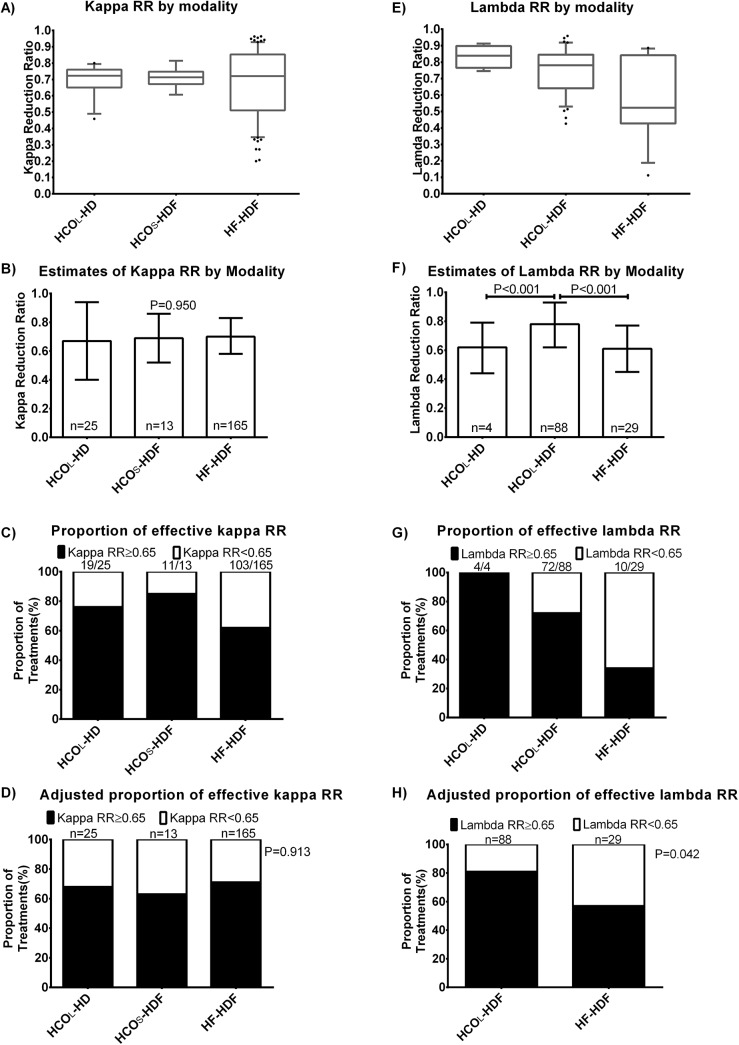
Free light chain reduction ratio by modality of renal replacement therapy.The left panel shows A) the crude reduction ratio (RR) of kappa free light chain by haemodialysis (HD) or haemodiafiltration (HDF) using large (2.1 m2) high cut-off filters (HCOL), small (1.1 m2) high cut-off filters (HCOS), and the 2.2 m2 heat sterilized high-flux polyphenylene HF (HF). Panel B shows the estimated marginal means of kappa reduction ratio taking into account repeated measurements within individuals and session duration using a GEE model. The percentages of the treatments with a kappa reduction ratio of ≥ 0.65 with each modality is shown in panel C. Panel D shows the percentages of the treatments with a kappa reduction ratio of ≥ 0.65 with each modality taking into account repeated measurements within individuals and session duration using a GEE model. The right panel shows the crude RR of lambda free light chain by renal replacement modality (E), and the estimated marginal means of lambda RR (F) taking into account repeated measures within individuals and session duration using GEE model. The crude and adjusted (within subjects and session duration) percentage of treatments with a lambda RR ≥0.65 are respectively shown in panels G and H. All p-values take into account adjustments for multiple comparisons using Bonferroni method.